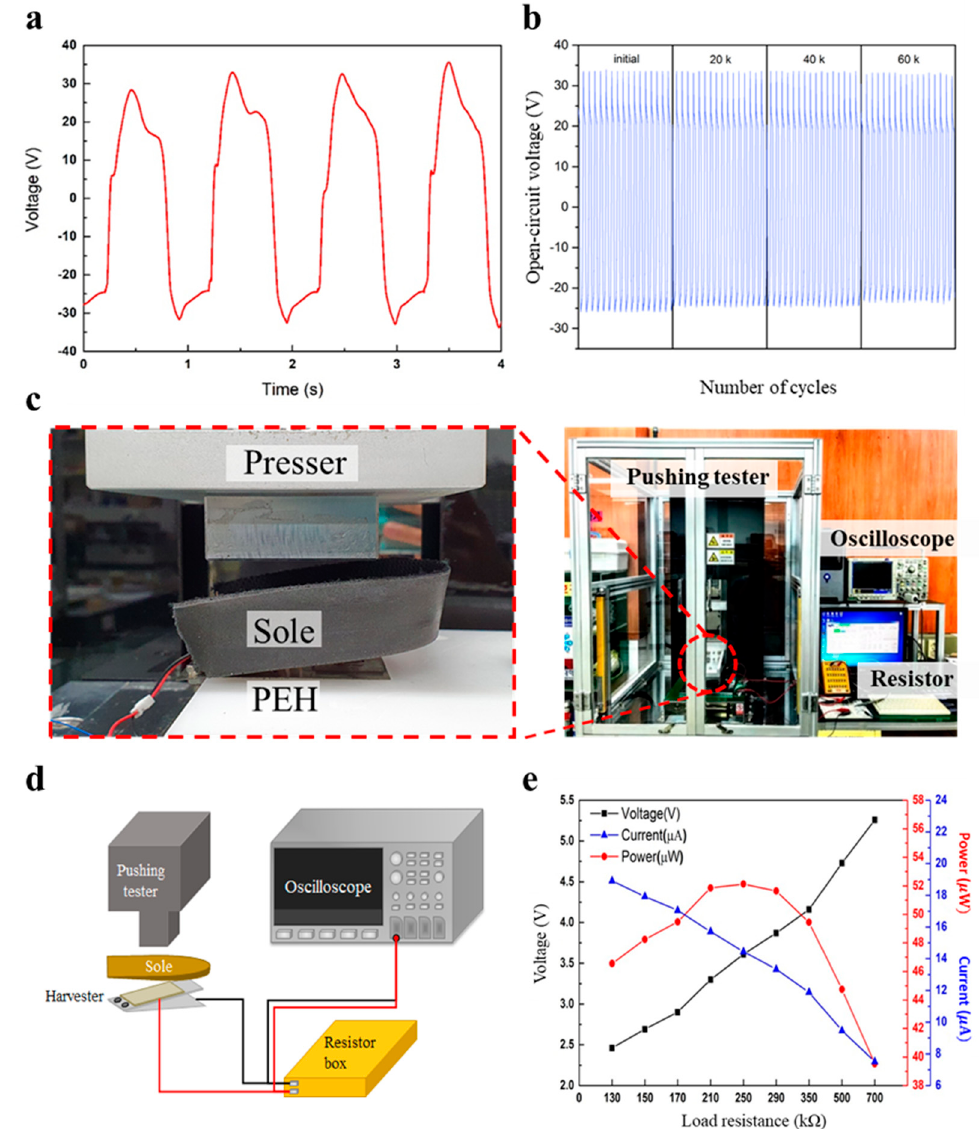
Figure 5. ( a ) Open-circuit voltage, ( b ) Number of cycles with the pushing tester, ( c ) Experimental setup, ( d ) block diagram of measurement system, ( e ) Graph of voltage, current, and power according to the load resistance.